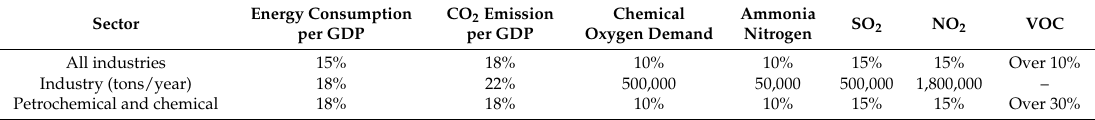
Table 1. National Programs of mitigation for certain